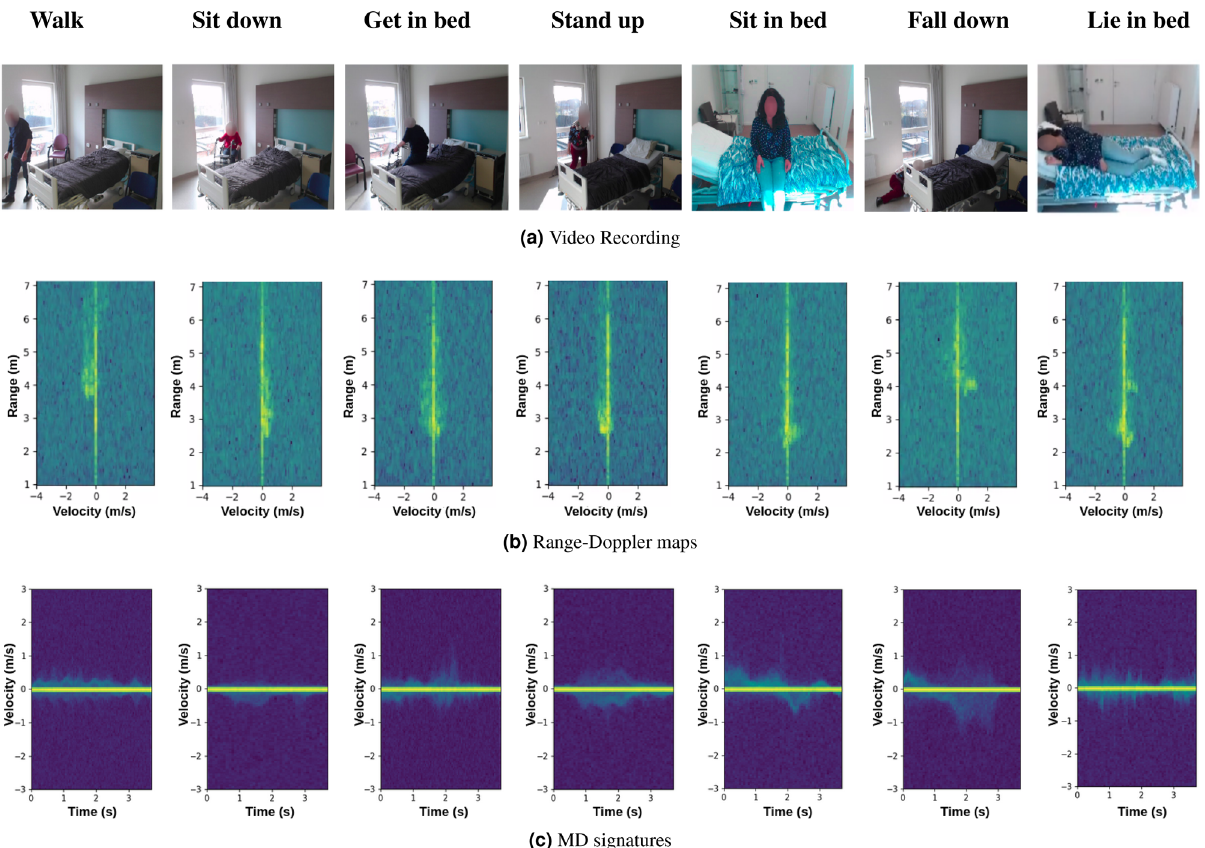
Figure 5. Visualisation of input data in different forms (adapted from Bhavanasi et al. 14 ). In ( a ) example activities are seen, ( b ) shows the corresponding Range–Doppler maps in dB, and ( c ) shows the MD signatures in